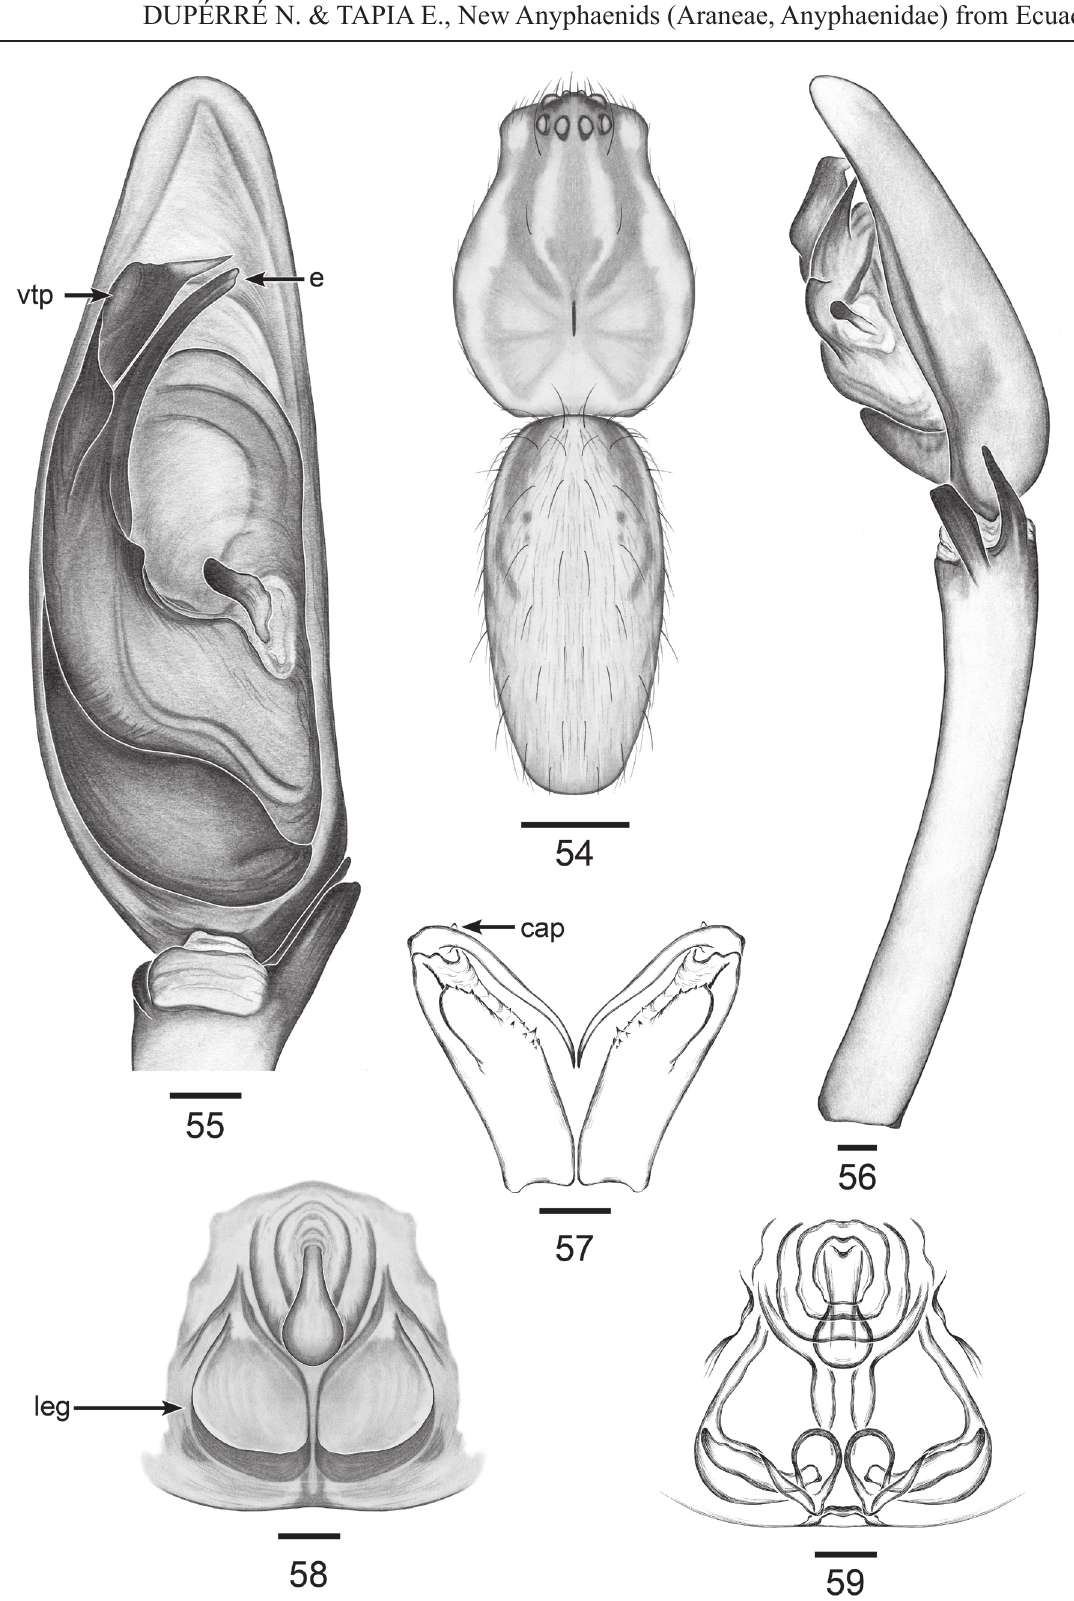
Figs 54–59. Patrera hatunkiru sp. nov. 54 . ♂, habitus, dorsal view. 55 . ♂, palp, ventral view. 56 . ♂, palp, retrolateral view. 57 . ♂, chelicerae, posterior view. 58 . ♀, epigynum, ventral view. 59 . ♀, internal genitalia, dorsal view. Scale bars: 55–56, 58–59 = 0.1 mm; 54 = 1 mm; 57 = 0.5